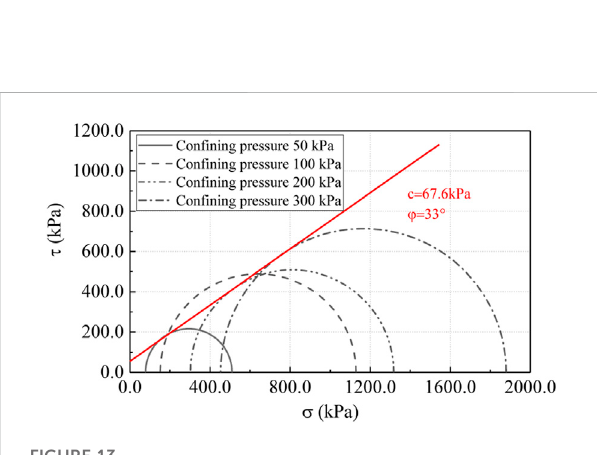
FIGURE 13 Shear strength of 0 days curing age specimen.